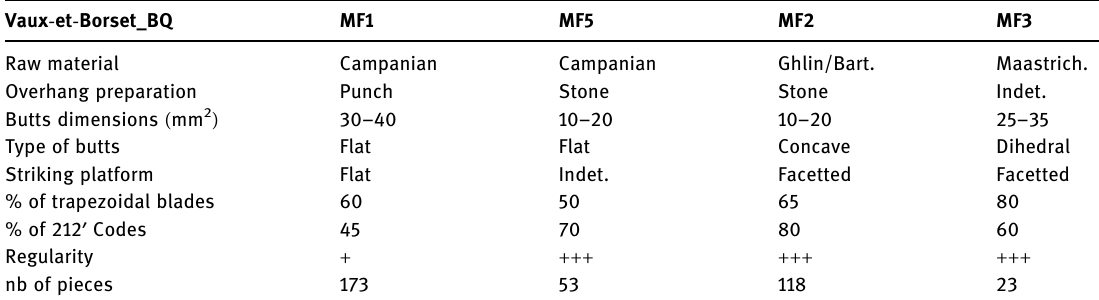
Table 4: Technical characteristics of the di ff erent “ ways of doing things ” identi fi ed on the BQ/VSG site of Vaux - et - Borset ( Hesbaye, Belgium ) Vaux - et - Borset_BQ